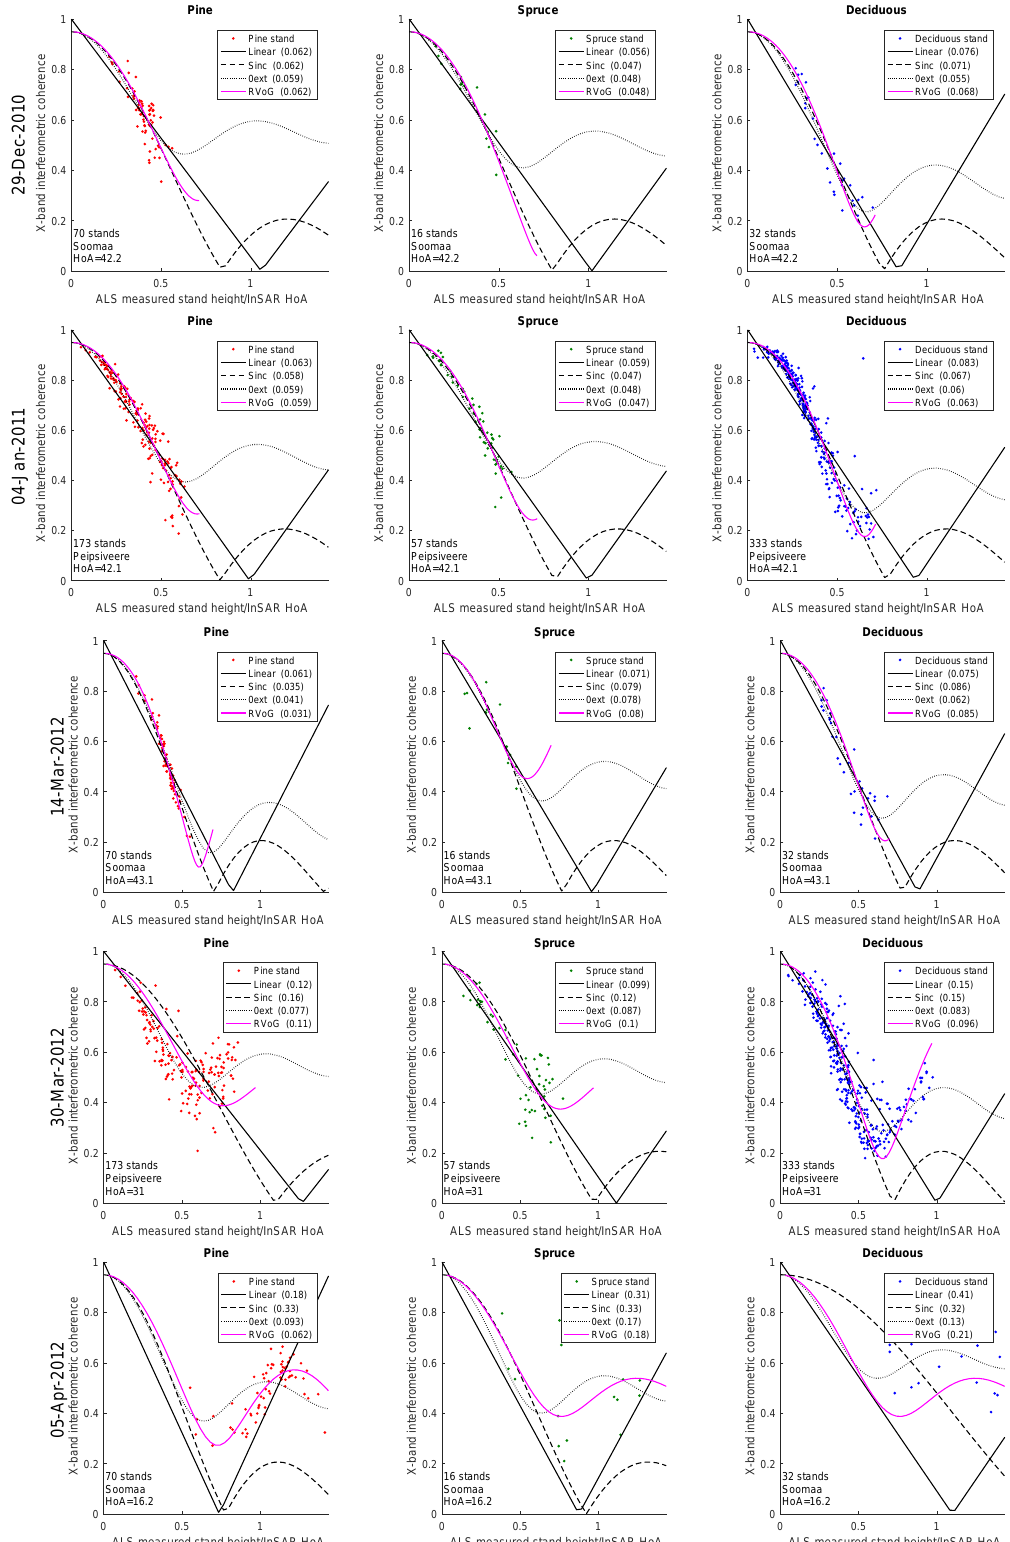
Figure 5. Four different models fitted to coherence and Airborne LiDAR Scanning (ALS) values for different TanDEM-X InSAR scenes. The fitting is performed separately for dominant tree species (>75% dominance); the first column presents pine stands (red), the second spruce stands (green) and the third deciduous stands (blue). Four different models (13), (14), (15) and (3) are presented as described in the legend. The goodness of fit parameter (RMSD) is also given within the brackets. The forest site and the HoA value for the scene is also given in the left corner of the